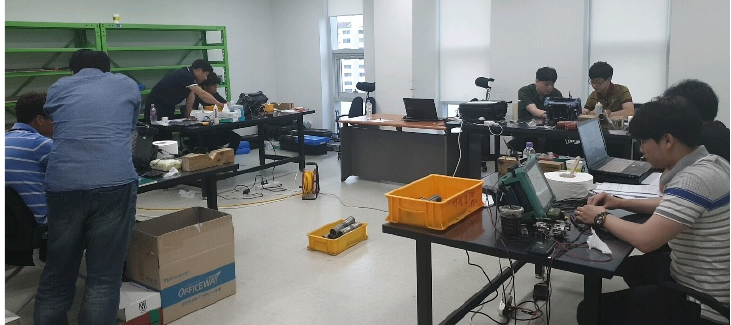
Figure 1. Picture of performing RRT for PAUT data acquisition.